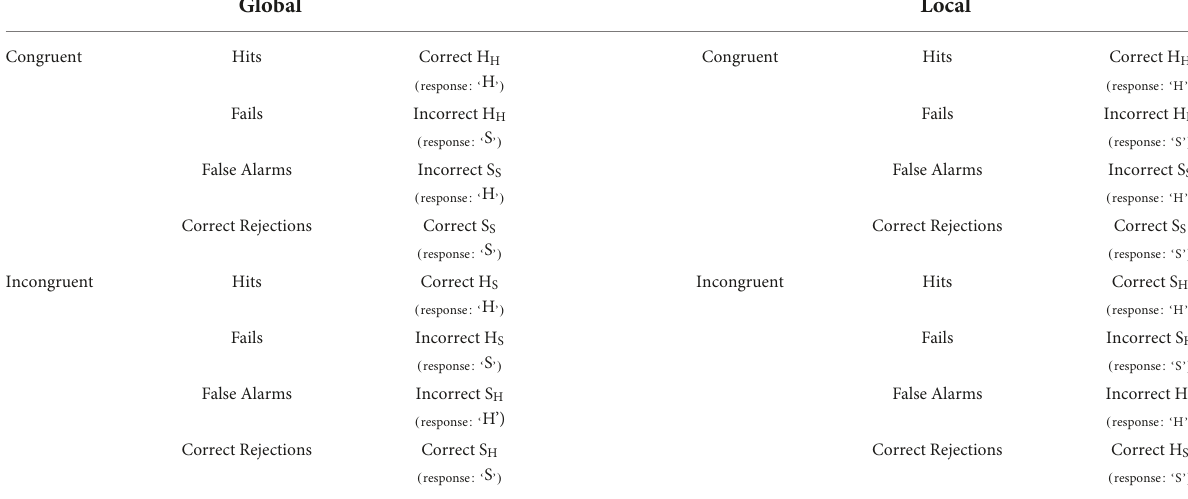
TABLE 2 Response categories for calculating discrimination sensitivity (d’).